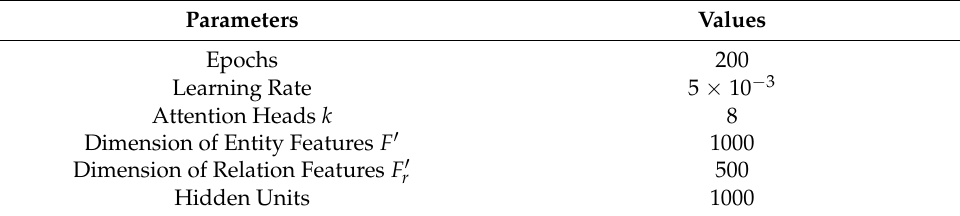
Table 2. The training parameters of MEGr-Net. Parameters Values Epochs 200 Learning Rate 5 × 10 − 3 Attention Heads k 8 Dimension of Entity Features F (cid:48) 1000 Dimension of Relation Features F (cid:48) r 500 Hidden Units